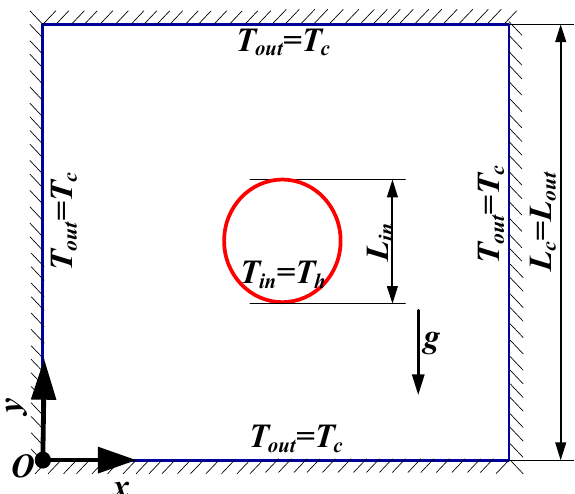
Figure 2. Set-up, consists of an annular space between an outer square enclosure (cold) and an inner circular cylinder (hot), considered for validating the present numerical method.